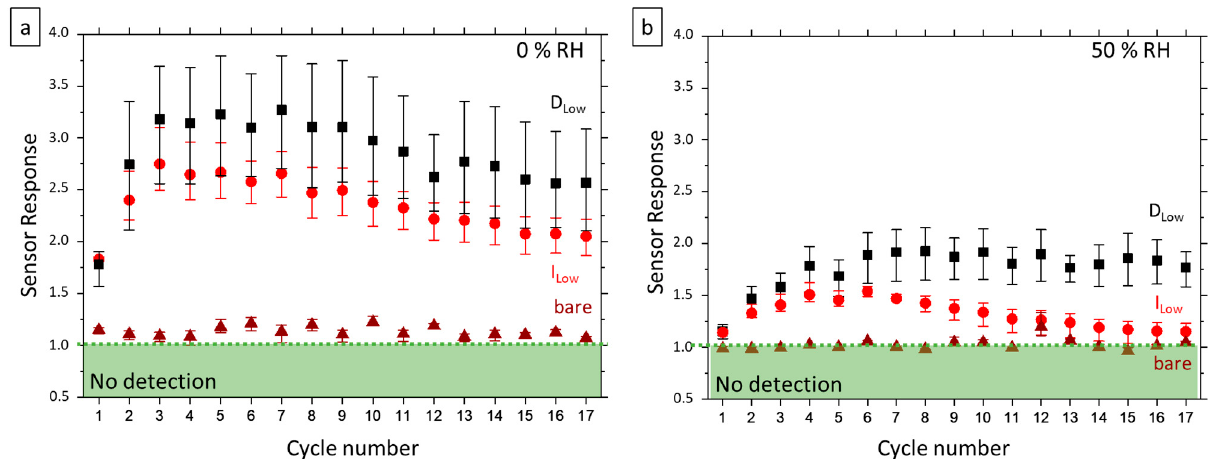
Figure 5. Evolution of D Low (black square), I Low (red circle) and bare (brown triangle) devices response for the whole “Humidity Study” ( a ) under dry atmosphere and ( b ) under 50% RH humid atmosphere. The sensor response is determined from the first exposure to 2 ppm of acetone. The symbol represents the mean calculated from 4 D Low devices and 3 I Low and bare devices. The upper and lower lines represent respectfully the higher and lower sensor responses calculated.